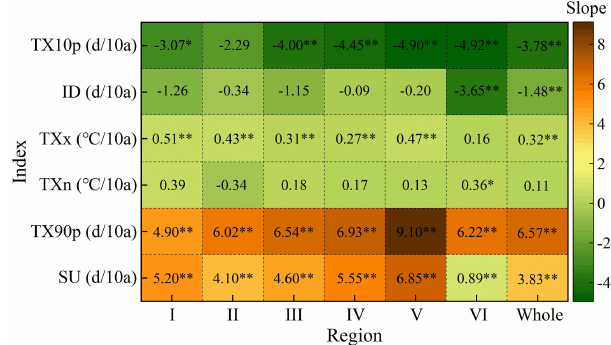
Figure 14. Variation trend of extreme temperature indices in differ- ent regions of China from 1979 to 2018. ( ∗ significant at the 0.05 level, ∗∗ significant at the 0.01